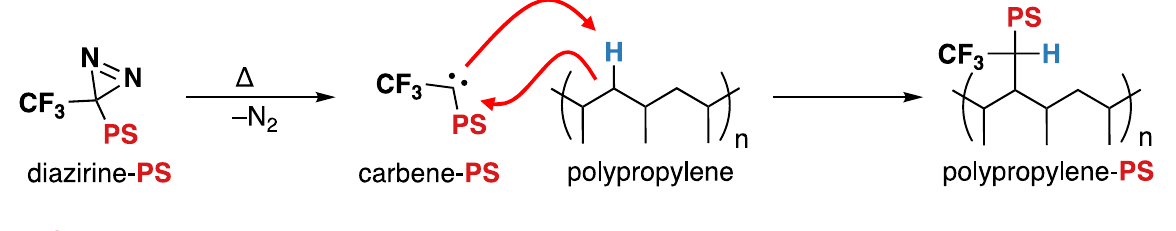
Figure 1. Strategy for creating covalently functionalized aliphatic polymer filters using diazirine C–H insertion chemistry and